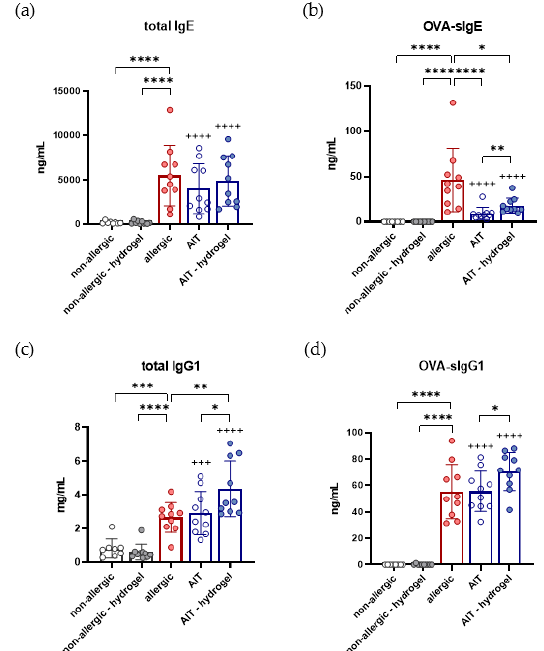
Figure 6. Effects of both AIT treatment strategies on the humoral immune response in a murine model of allergic asthma. Measurement of total IgE ( a ), OVA-sIgE ( b ), total IgG1 ( c ), and OVA-sIgG1 ( d ) in serum samples at the endpoint of the experiment ( n = 10). Gaussian and non-Gaussian distributed results were analyzed by unpaired t-test or Mann–Whitney test, respectively. p -values of ≤ 0.05, ≤ 0.01, ≤ 0.001, and ≤ 0.0001 are shown as *, **, ***, and ****, respectively. p -values of AIT groups compared to the respective non-allergic groups are shown as +++ and ++++, respectively.